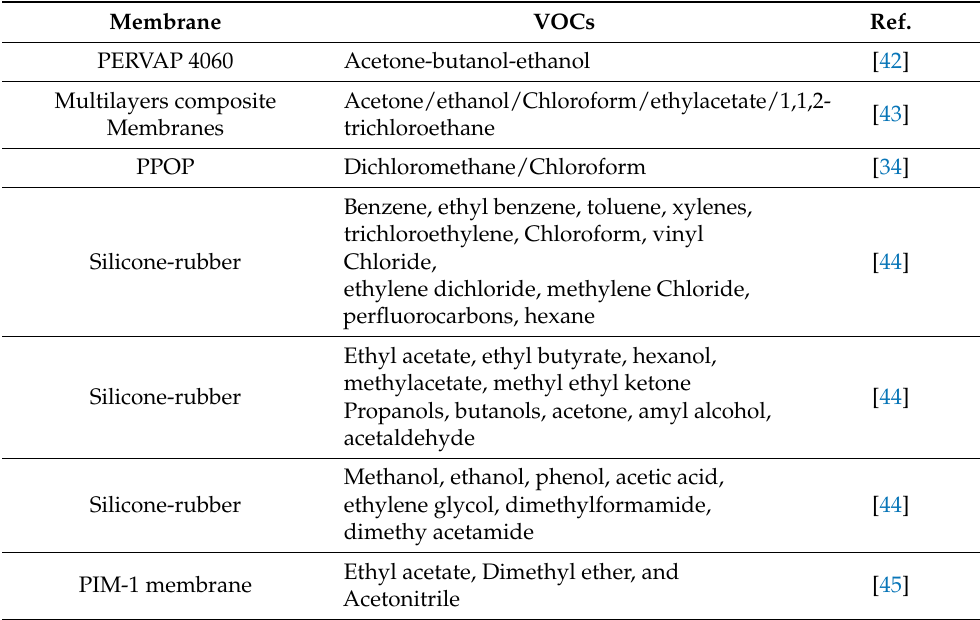
Table 2. Some VOC multicomponent/water systems separated from water by a pervaporation technique using different